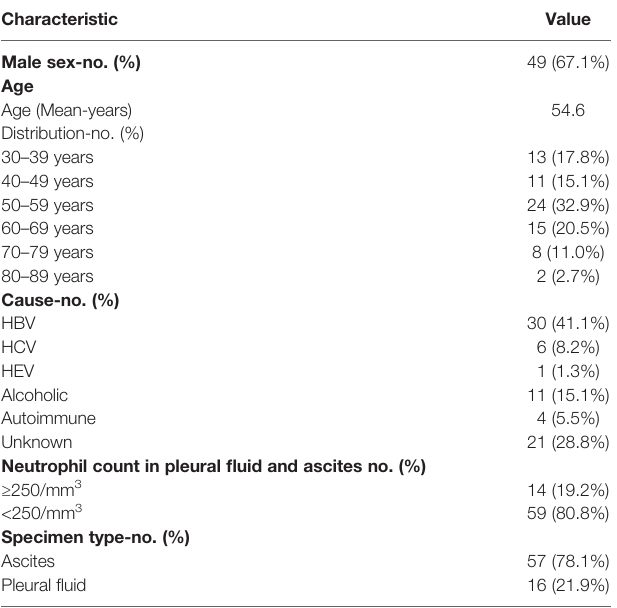
TABLE 1 | Demographic and clinical characteristics of the 73 patients. Characteristic